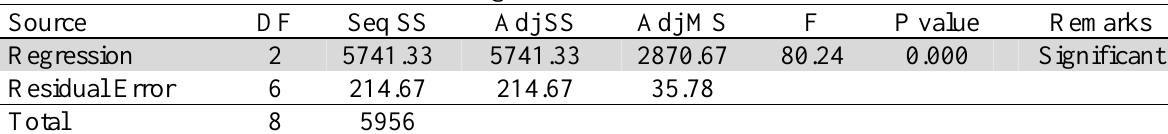
ANOVA table of 1 st order model for cutting force (F)